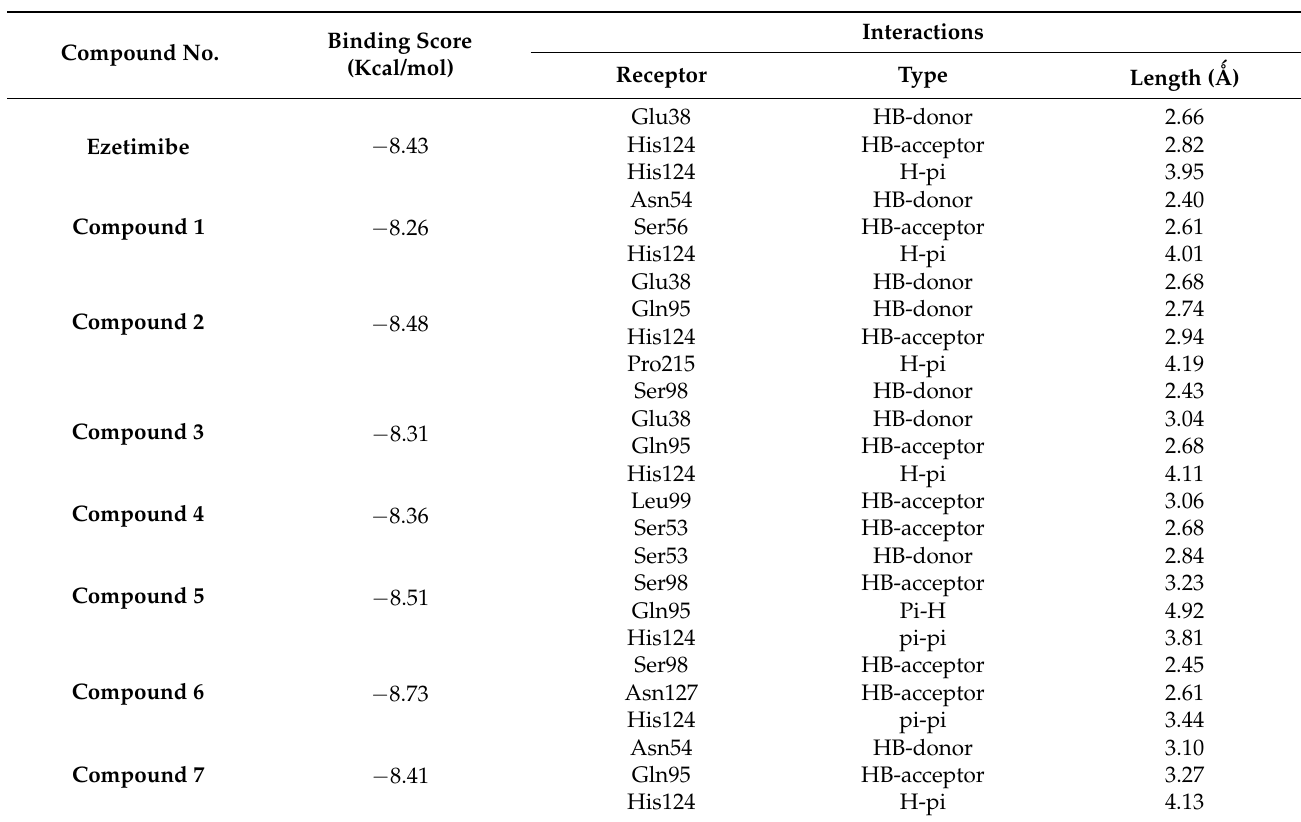
Table 4. Interaction types and binding scores for the formed complexes of Ezetimibe or compounds 1 – 7 with the active sites of NPC1L1 (pdb: 3QNT) performed using MOE 2019.01. Compound